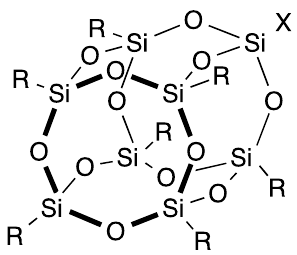
Molecules 2018 , 23 , x FOR PEER REVIEW 2 of 10